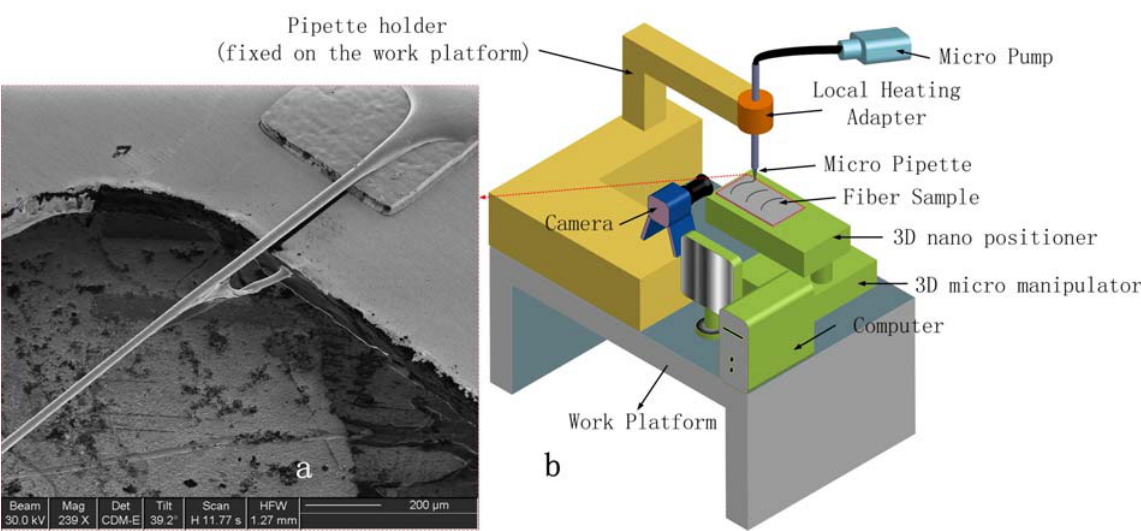
Figure 7. The thermo-direct drawing system; (a) suspended PVDF aligned micro/nano fibers (about 25 µm in diameter) on Kapton (thickness 50 µm), (b) scheme of PVDF direct drawing setup.